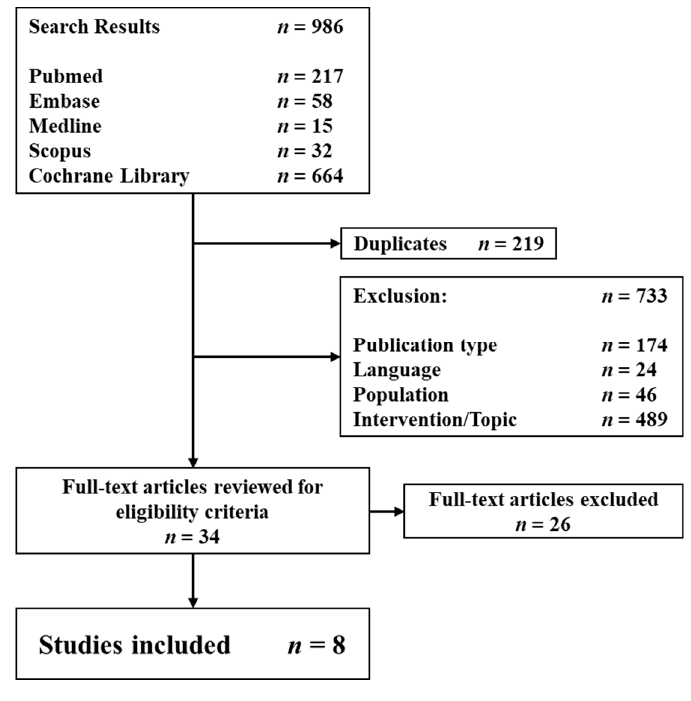
Figure 1. Flow chart of study inclusions and exclusions.